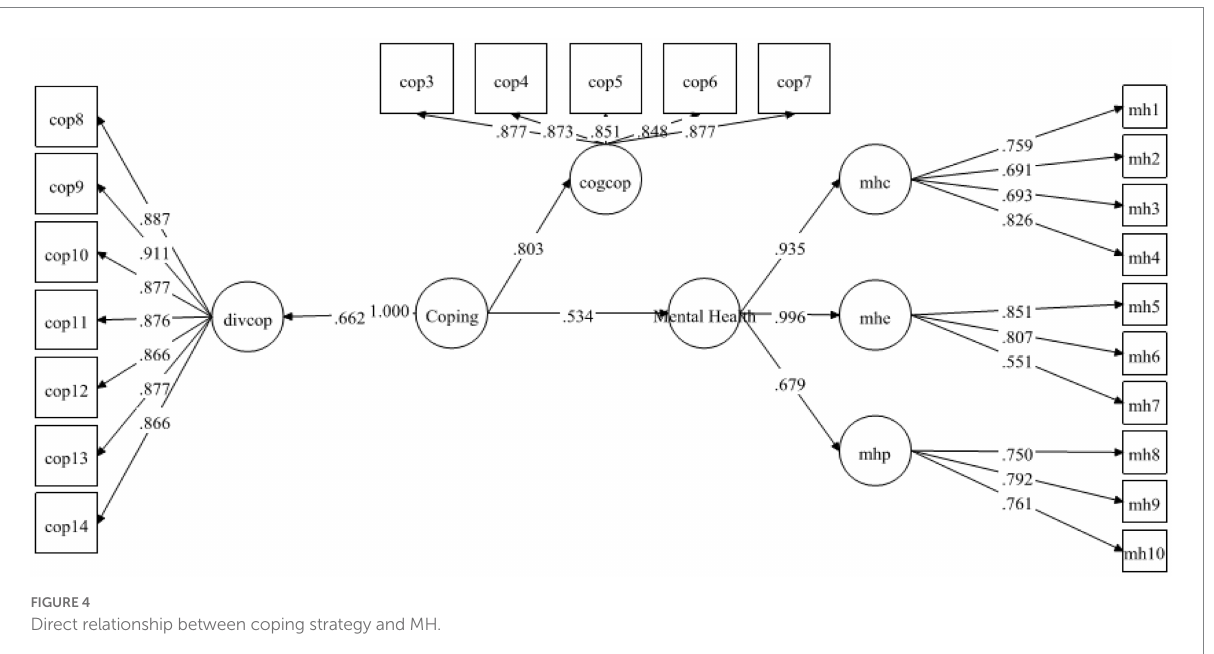
FIGURE 4 Direct relationship between coping strategy and MH.